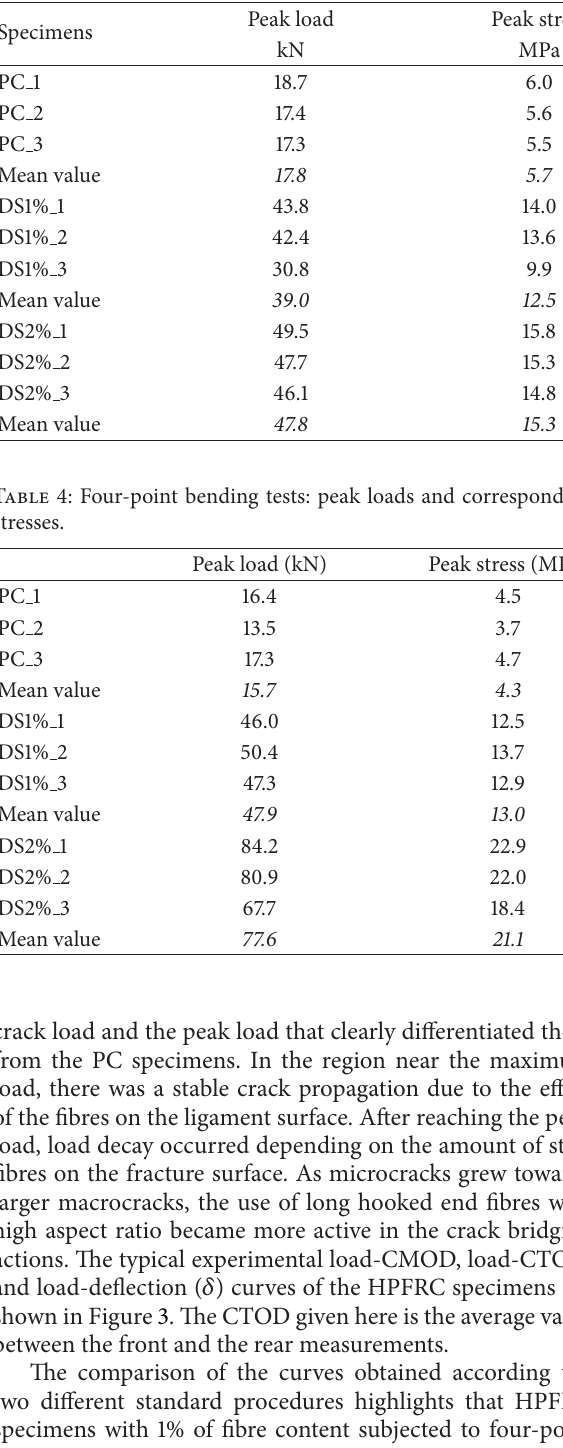
Table 3: Three-point bending tests: peak loads and corresponding stresses.